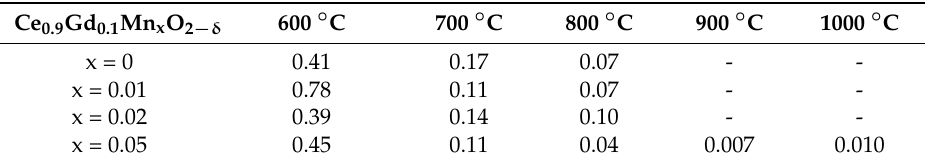
Table 3. Electronic transference numbers t e for the different samples at chosen temperatures. Data for 900 and 1000 ◦ C were determined from permeation